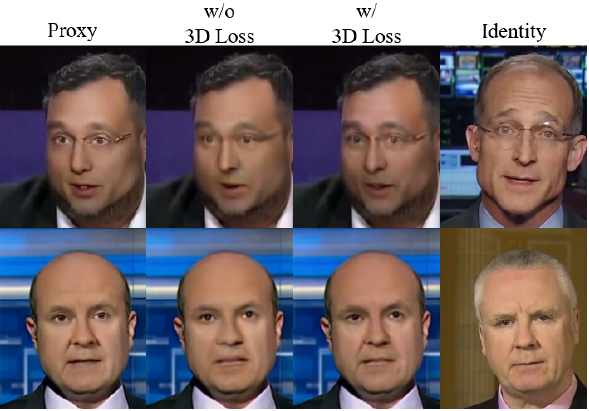
Figure 5. Ablation study on 3D loss. Under the constraint of 3D loss, the generated result can obtain more detail information and make results more realistic.